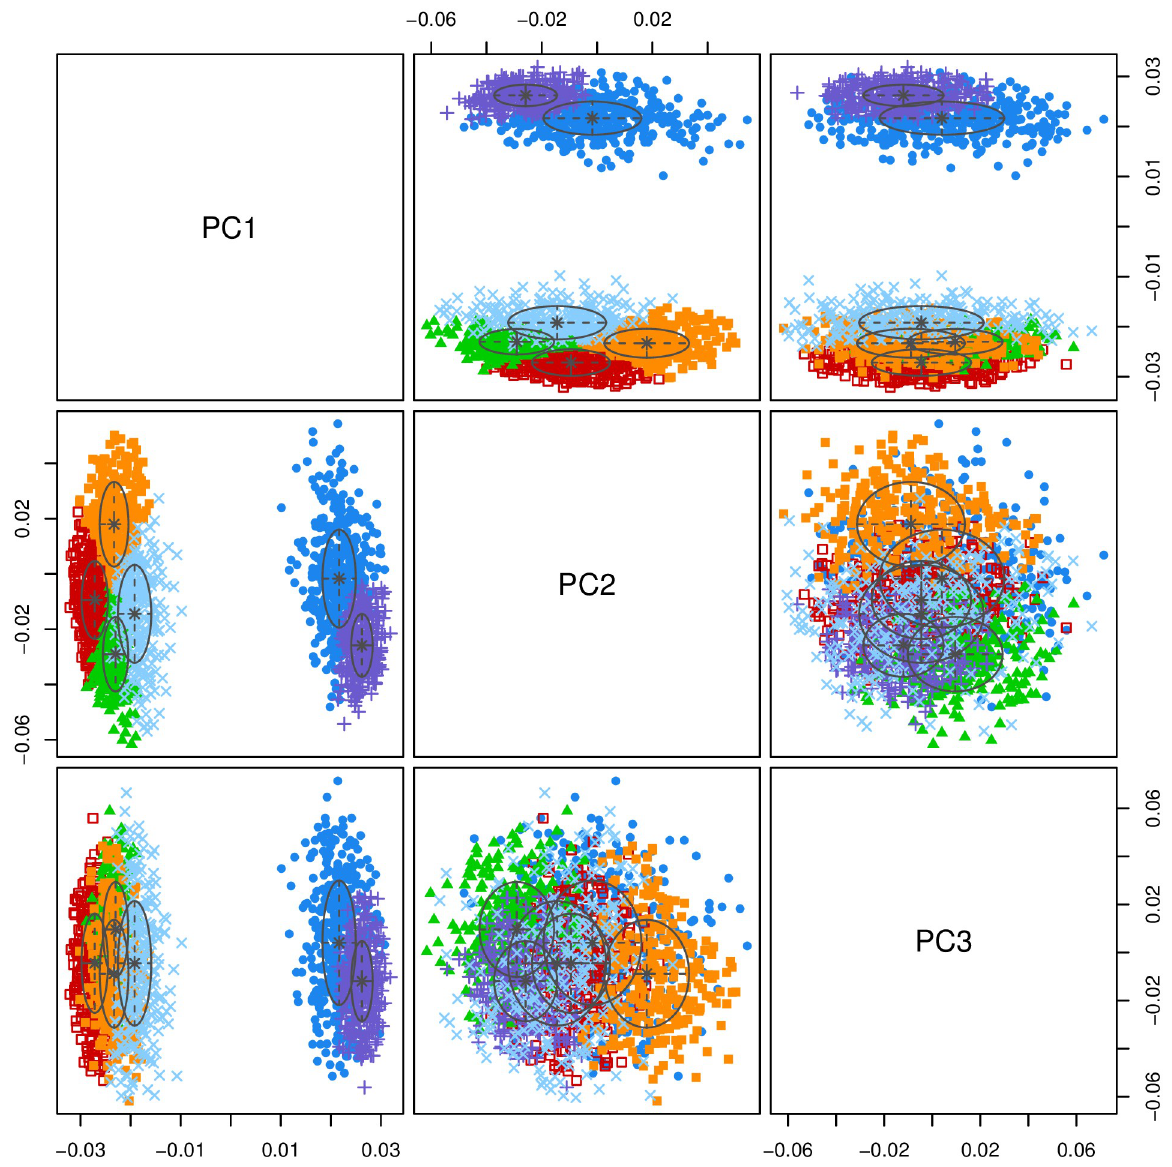
Fig 4. Mclust graph. The x-axis and y-axis represent the top three components. Different groups are marked with differentcolors. https://doi.org/10.1371/journal.pone.0253219.g004 In Fig 5, the horizontal axis is the number of genes enriched to each function, and the verti- cal axis is the function term. We use seven colors to mark seven different gene sets. According to the most significant top3 function of each subset selected (gene set6 only enriched to two functions), it can be observed that each gene subset has a specific function annotation. For example, the gene set1 focuses on the cell generation stage, including cytoskeleton and micro- tubule formation. Geneset2 focuses on the insulin pathway, autophagy, and mRNA process. Gene set3 concentrates on the interaction between cells, including platelet activity, cell adhe- sion, lipopolysaccharide response, etc. Gene set4 focuses on transcription regulation, including positive regulation, negative regulation, ubiquitination, and so on. Gene set5 focuses on hor- mones, chemokines, and other body fluid regulation. Gene set6 focuses on protein stability